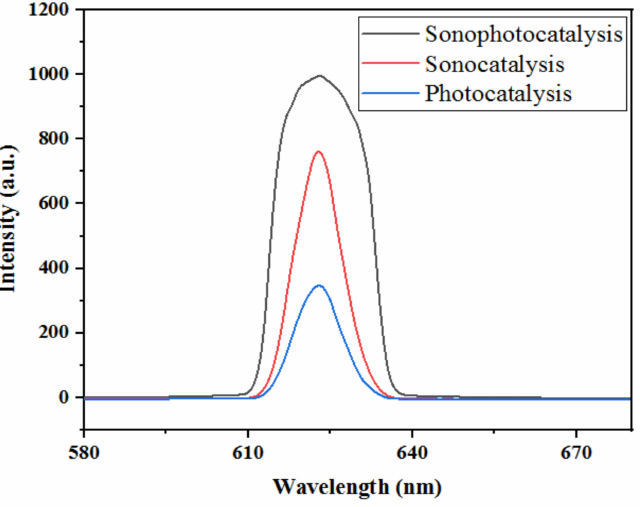
Figure 20. Trapping experiment: terephthalic acid tests for sonophotocatalytic, sonocatalytic and photocatalytic degradations of